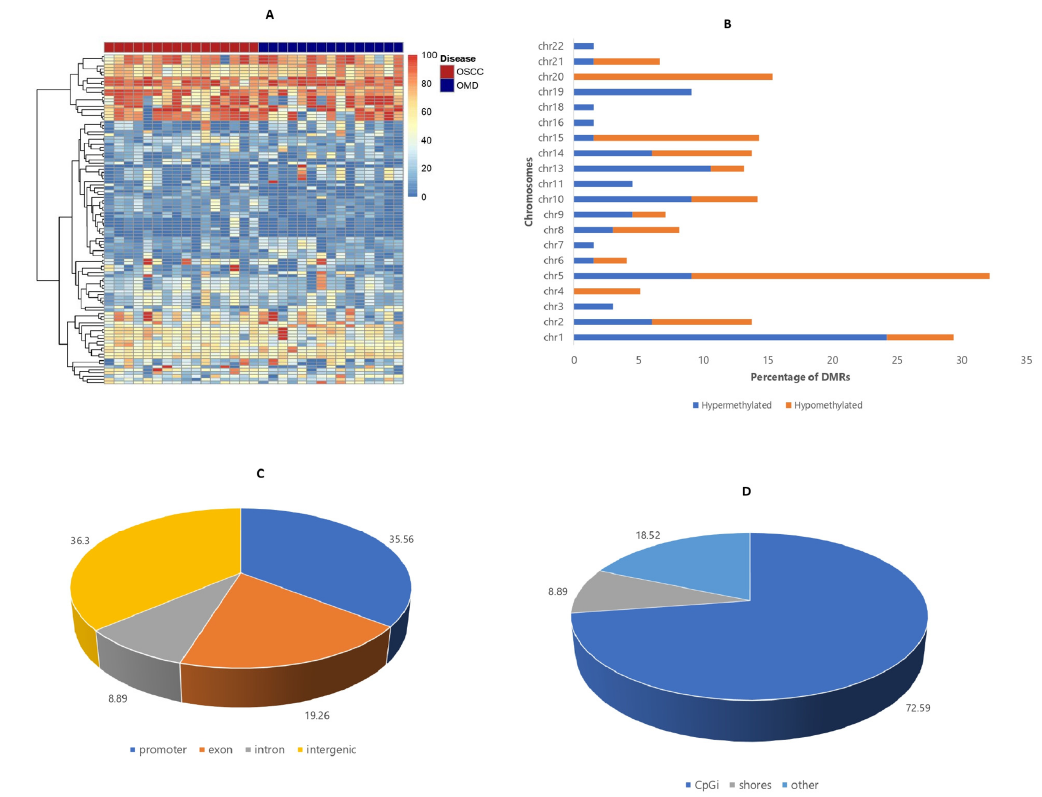
Figure 4. 100 bp regional methylation analysis for description of DMRs. ( A ) Heatmap comprising the methylation percentages of aberrantly methylated regions in all samples. ( B ) Autosomal annotation of DMCs. ( C ) Genomic annotation of DMRs. ( D ) CpG island annotation of DMRs.